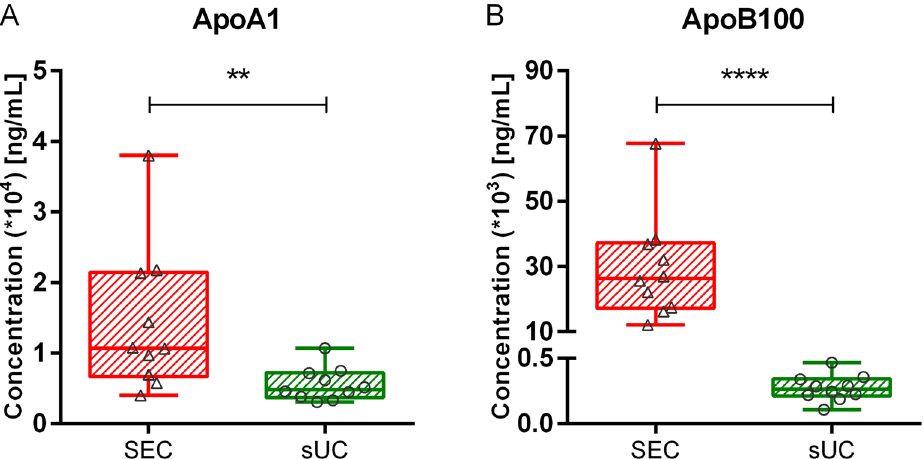
Figure 5. Quantification of ApoA1 and ApoB100 with ELISA in SEC and sUC EV-enriched samples. Box and whiskers plot of ( A ) ApoA1 and ( B ) ApoB100 concentrations in samples after SEC and sUC. Each circle or triangle presents one sample. N = 10. ** p < 0.01, **** p < 0.0001. ApoA1 Apolipoprotein A1, ApoB100 Apolipoprotein B100, sUC sucrose cushion ultracentrifugation, SEC size exclusion chromatography.